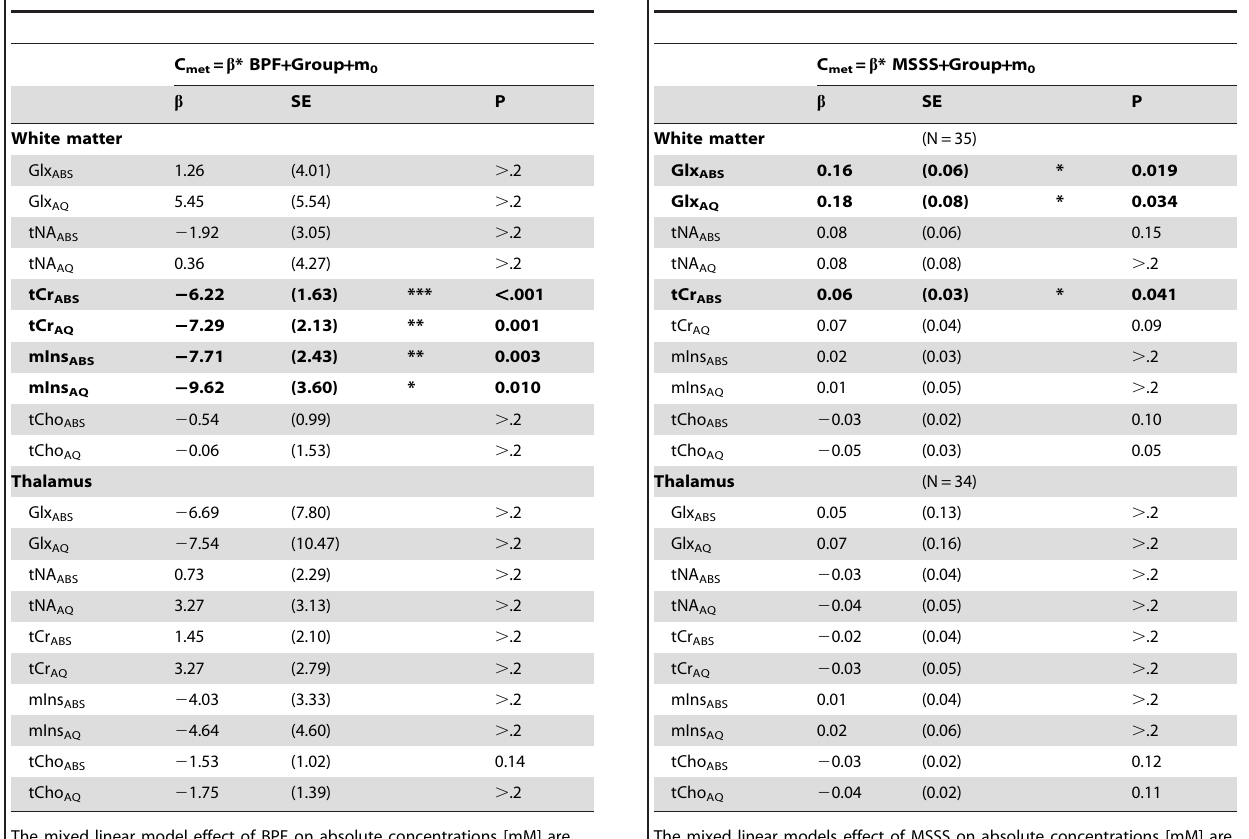
Table 3. Association between metabolite concentration and brain parenchymal fraction (BPF).